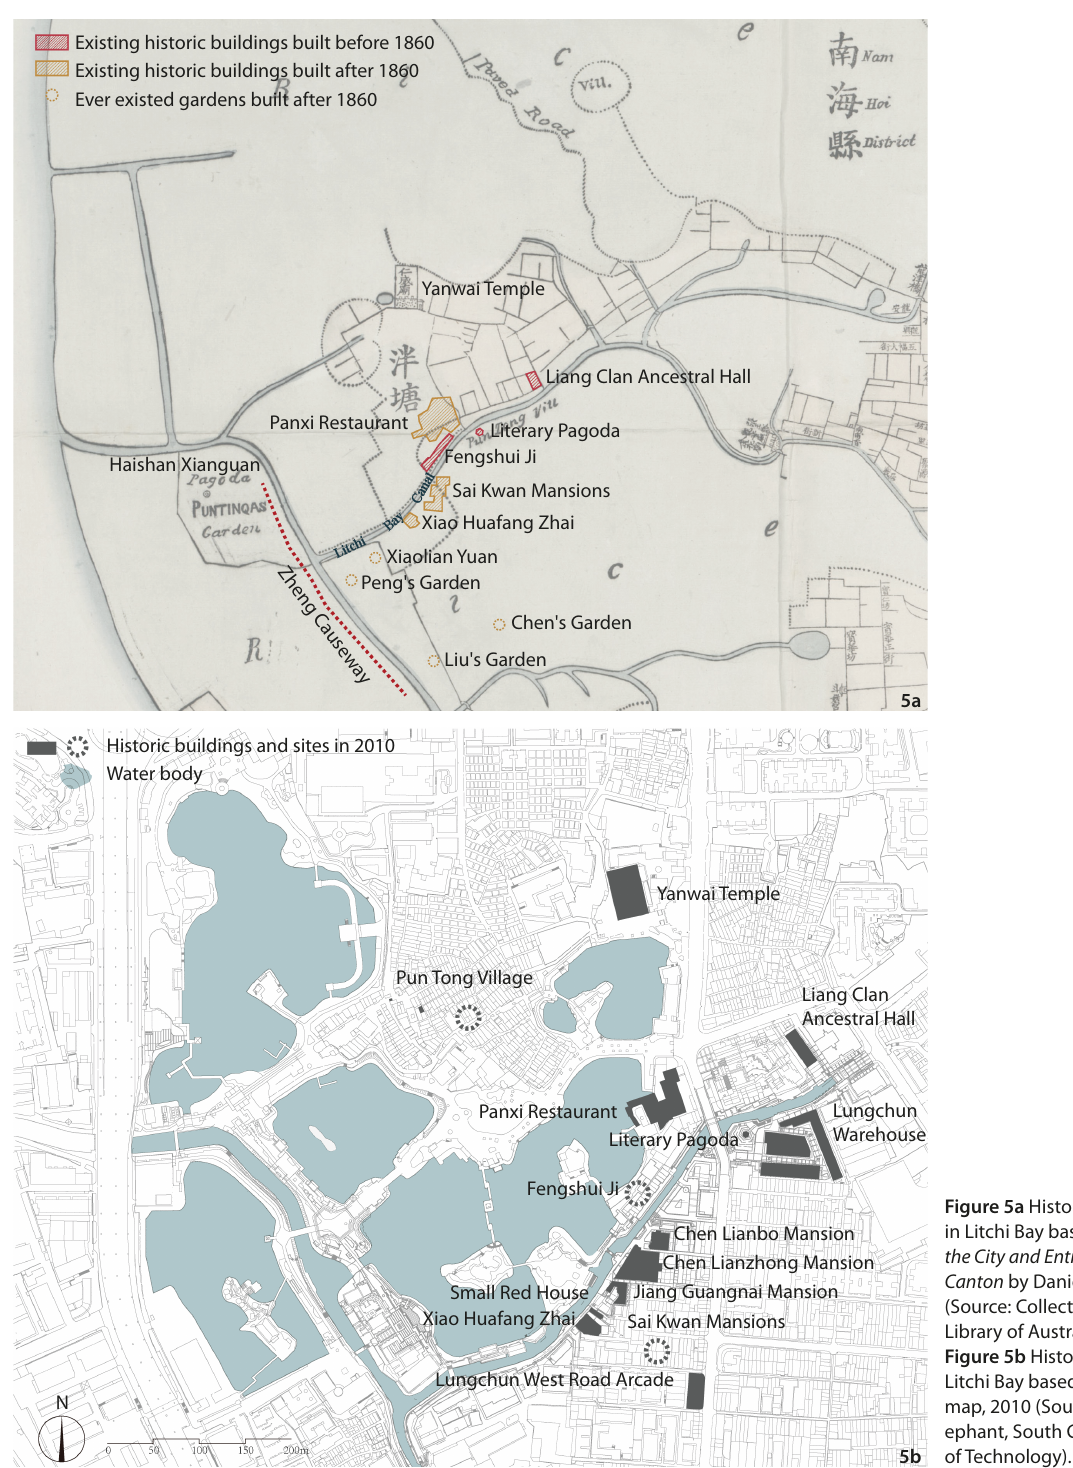
Figure 5a Historic landscape in Litchi Bay based on Map of the City and Entire Suburb’s of Canton by Daniel Vrooman, 1860 (Source: Collection of National Library of Australia). Figure 5b Historic landscape in Litchi Bay based on topographic map, 2010 (Source: Urban El- ephant, South China University of